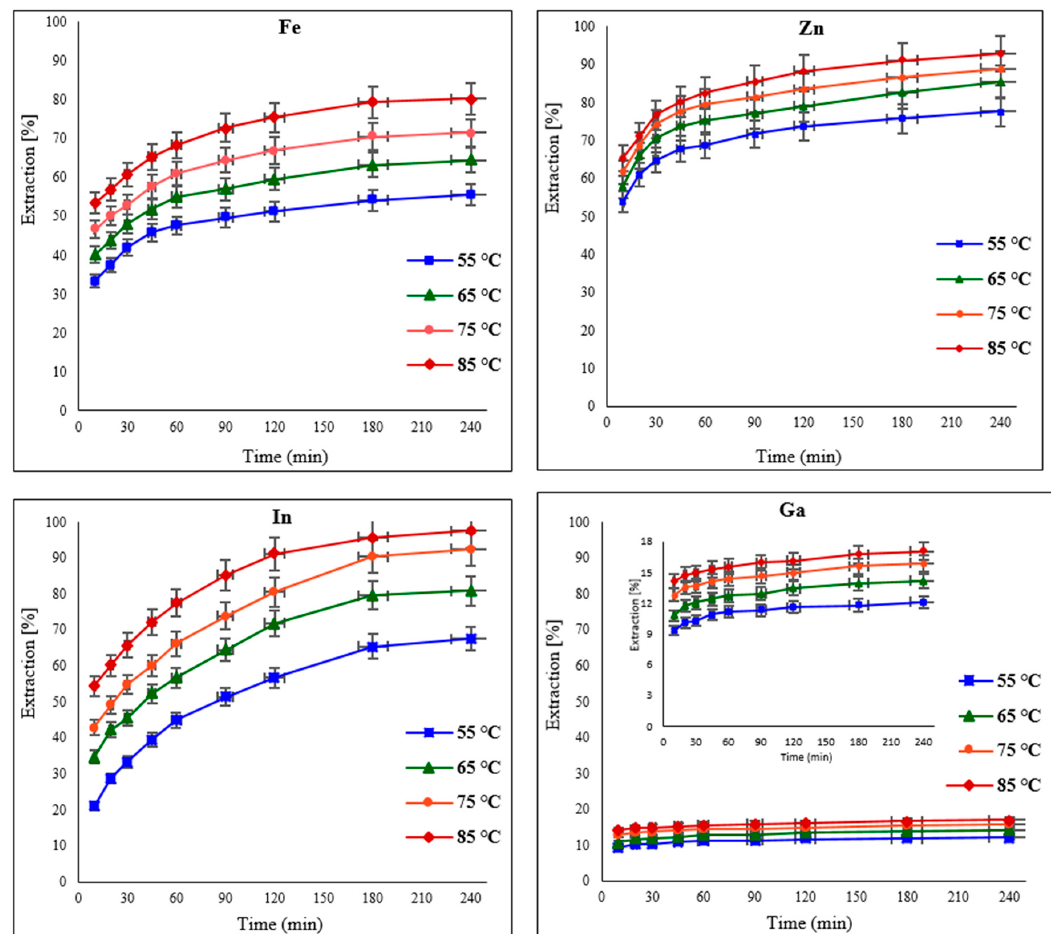
Figure 8. Effect of varying temperatures (55, 65, 75, and 85 °C) on the extraction of Fe, Zn, In, and Ga from EAFD. Experimental conditions: 100 mL of 30% v / v [Bmim + HSO 4 − ], 1 g of oxidant Fe 2 (SO 4 ) 3 , S/L ratio of 1/20, stirring speed of 500 rpm, and total leaching time of 4 h (240 min).